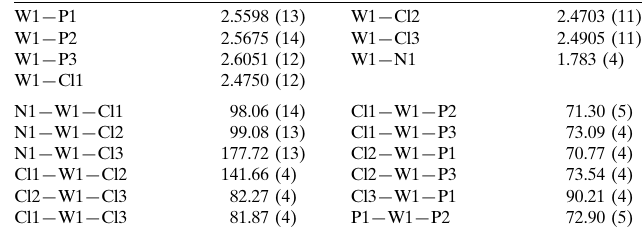
Selected geometric parameters (A˚ , (cid:4) ).